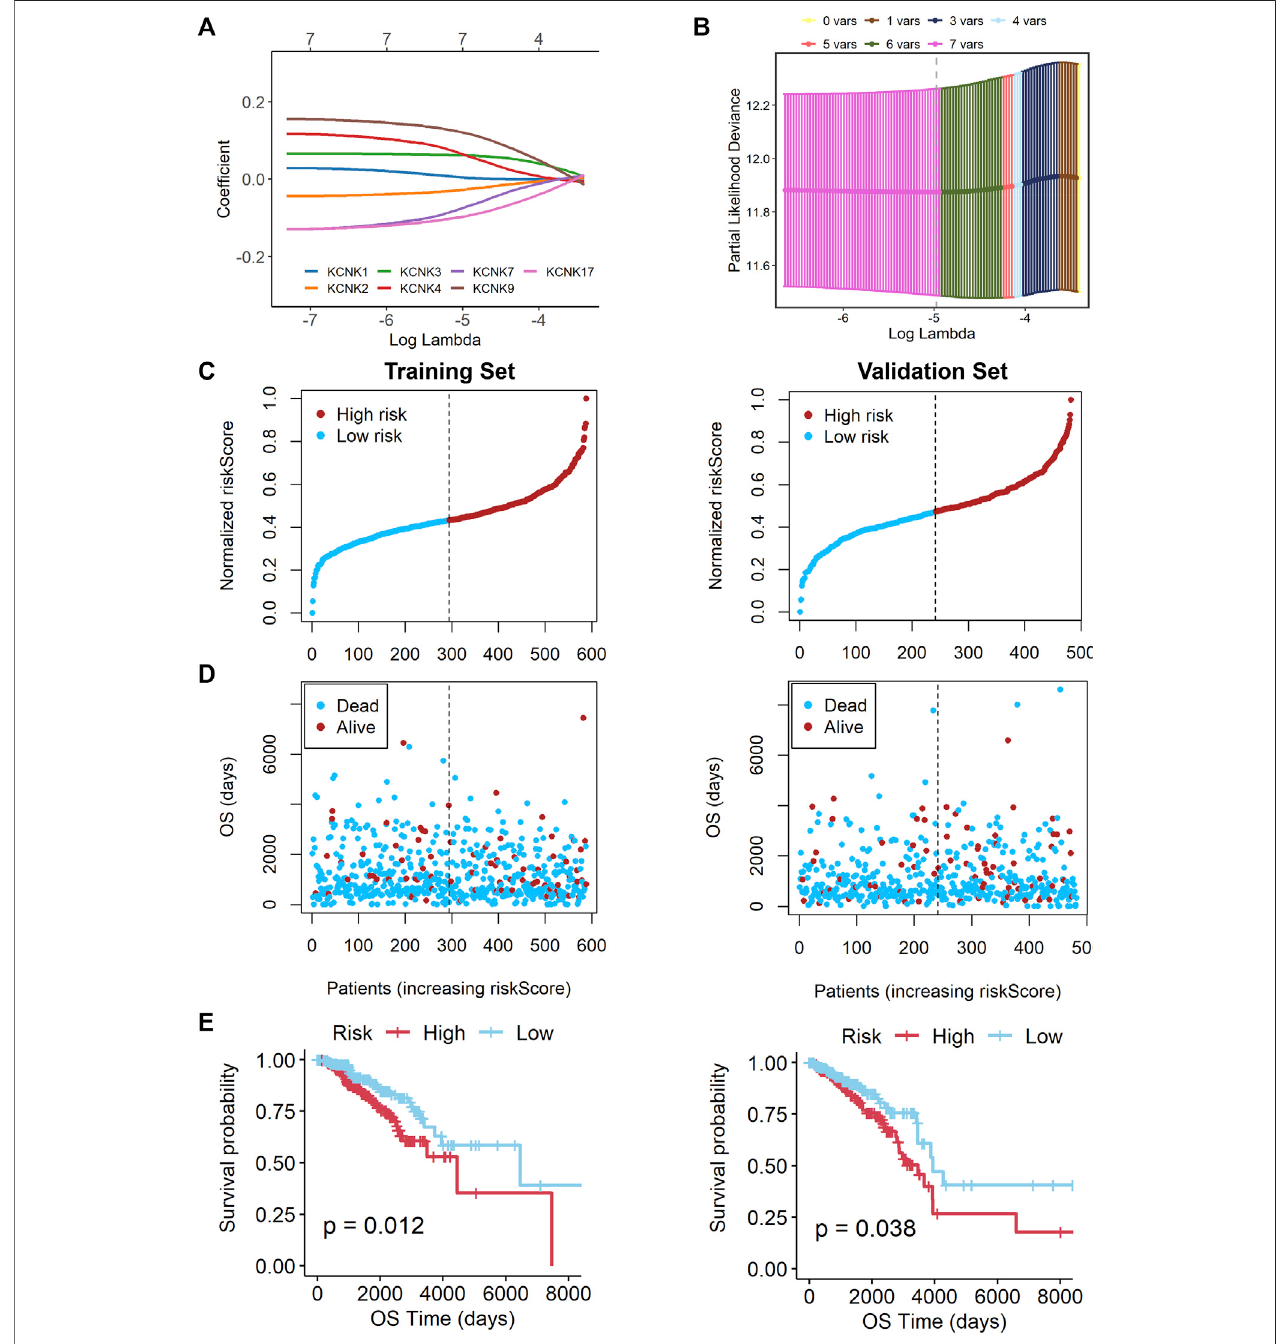
FIGURE 5 | Construction of a KCNK-based prognostic signature for breast cancer. (A) Selection of the seven model KCNK genes in lasso regression model. (B) Cross-validation of the constructed signature. (C,D) Distribution of adjusted risk score in the training and validation cohorts. (E) Overall survival (OS) in the low- and high-risk group patients in the training and validation cohorts. The speci fi c prognostic signature with seven KCNK genes was established, which manifested accuracy in predicting the prognosis of breast cancer in both training and validation cohorts.